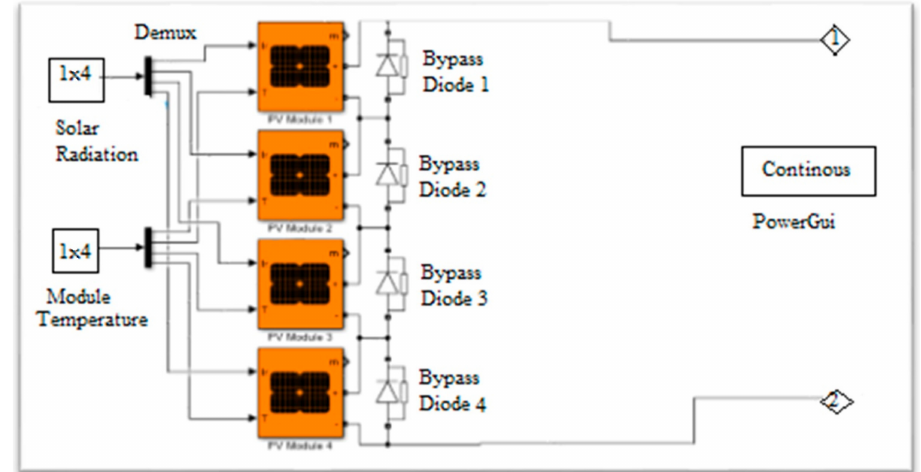
Figure 15. PV Array Modeling in Simulink.